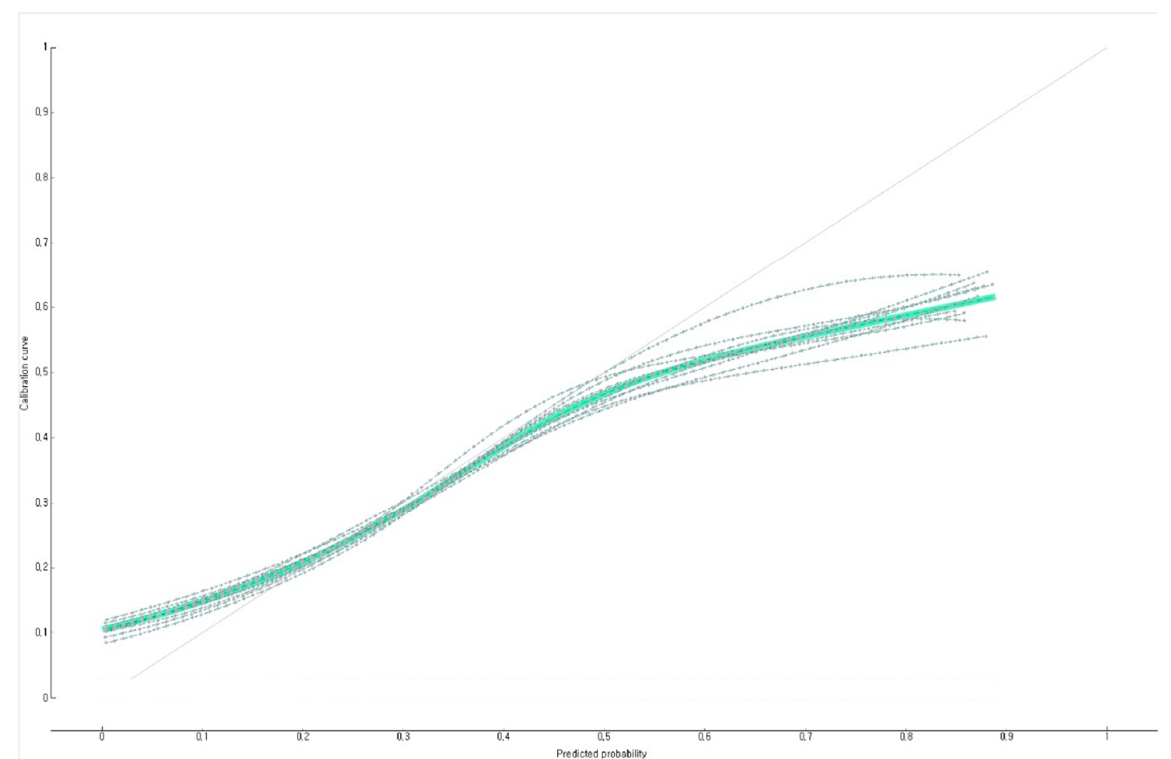
Figure 4. Calibration plot (10-fold validation) of Bayesian nomogram for predicting the subjective life dissatisfaction of Korean adults in COVID-19 pandemic in Korea